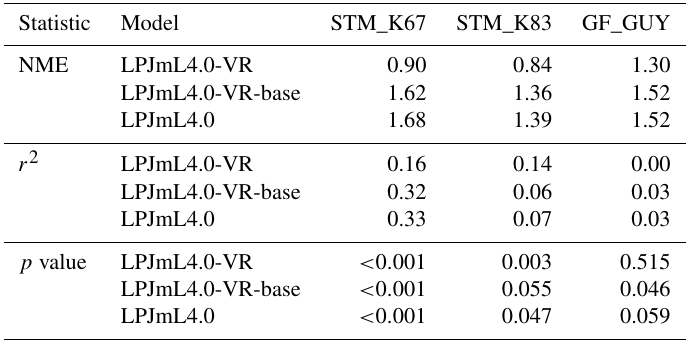
Table B2. Normalized mean error (NME), coefficient of determination ( r 2 ) and p value of F statistic piecewise calculated for simulated NEE of the different LPJmL model versions used in this study forced with CRU climate input and FLUXNET data of NEE at three FLUXNET sites (in accordance with Fig. B7).